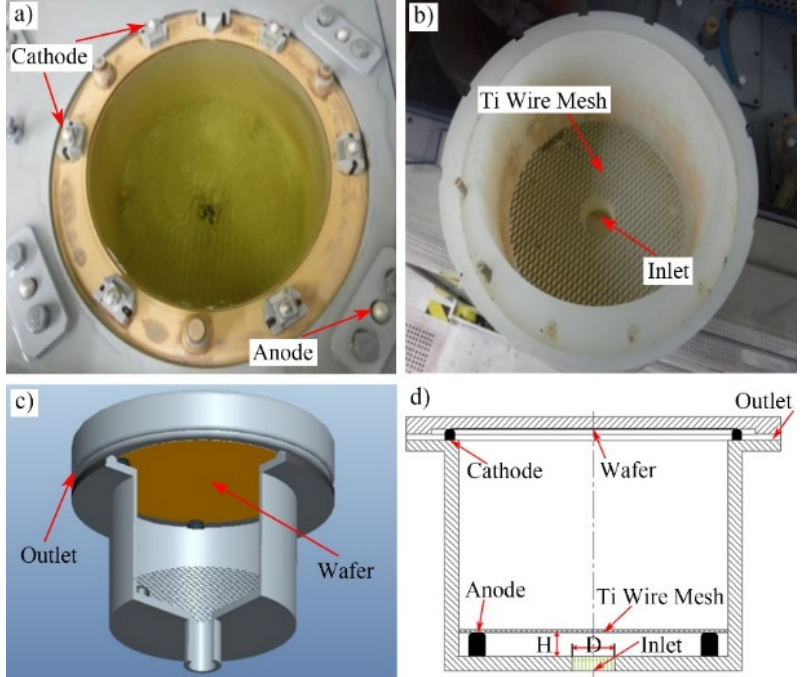
Figure 1. Structure of Au bump electroplating cup. ( a ) Electroplating process without wafer, ( b ) Empty electroplating cup with Ti wire mesh, ( c ) 3D model of electroplating structure with wafer, ( d ) Schematic diagram of electroplating cup.